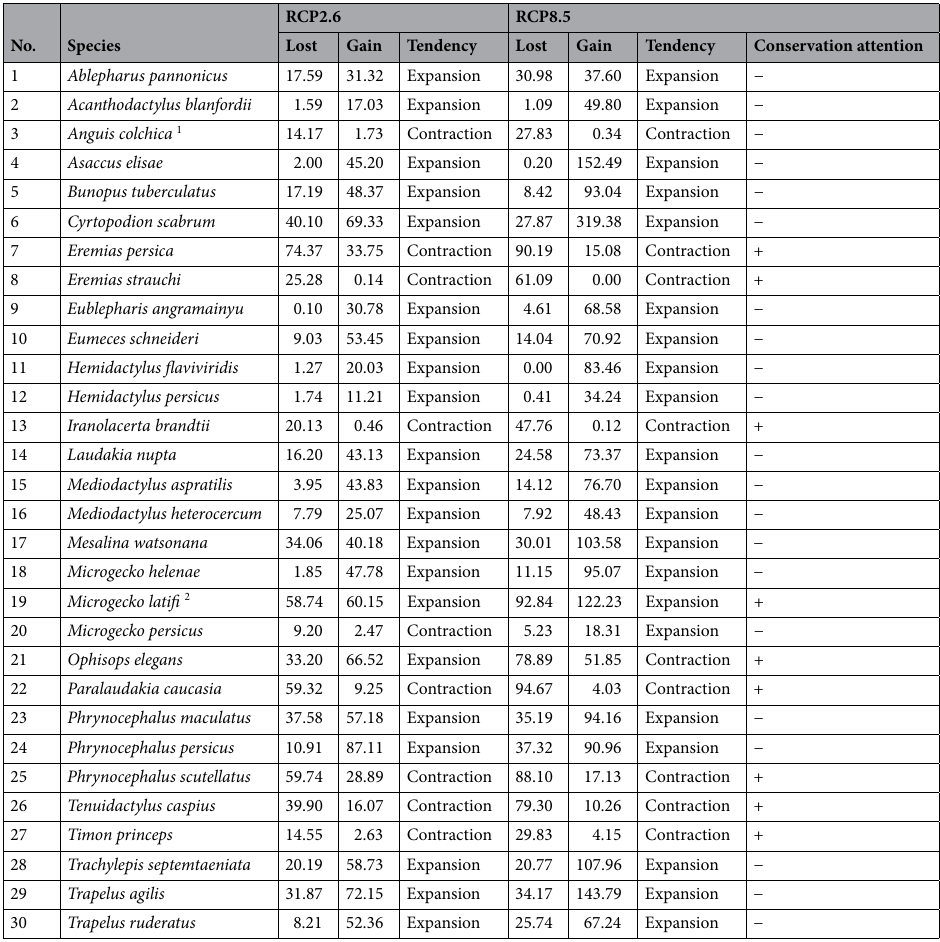
Table 3. Species range change (gain/loss) of 30 lizard species in recently suitable habitats by 2070 under optimistic (RCP2.6) and pessimistic (RCP8.5) scenarios in Iran. Species that are threatened by future climate change have also been identified. 1 Although habitat loss is greater than new habitat gain, the majority